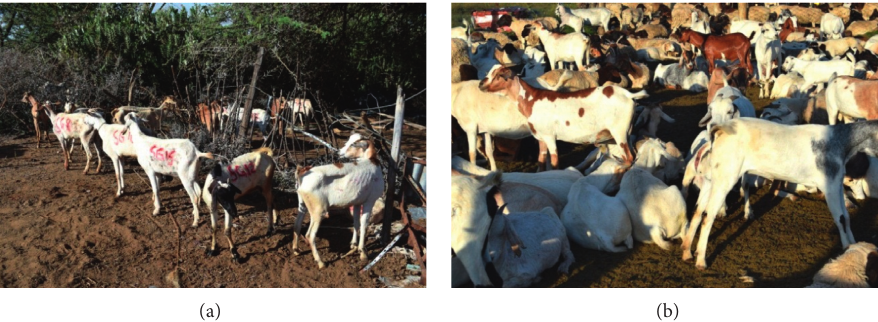
Figure 3: (a) Goats in poor body condition (sick goats) that had consumed Opuntia stricta in Laikipia North sub-County. (b) Goats in good body condition (controls) that had not consumed Opuntia stricta in a ranch in Laikipia North sub-County. Table 1: Criteria used to score external and internal lesions of goats feeding on Opuntia stricta in Laikipia North sub-County. Lesions